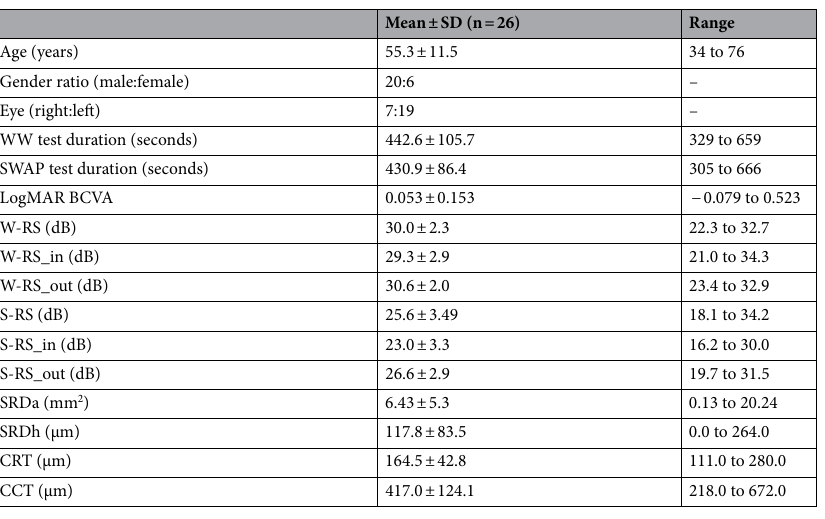
Table 1. Subject demographics. WW white-on-white automated perimetry, SWAP short wavelength automated perimetry, logMAR BCVA logarithm of the minimum angle of resolution of best-corrected visual acuity, SRD serous retinal detachment, W-RS mean overall RS of WW, W-RS_in mean RS inside the SRD regions in WW, W-RS_out mean RS outside the SRD regions in WW, S-RS mean overall RS of SWAP, S-RS_in mean RS inside the SRD regions in SWAP, S-RS_out mean RS outside the SRD regions in SWAP, SRDa area sum of all observed SRD regions (foveal and extra-foveal), SRDh SRD height at the fovea, CRT central retinal thickness, CCT central choroidal